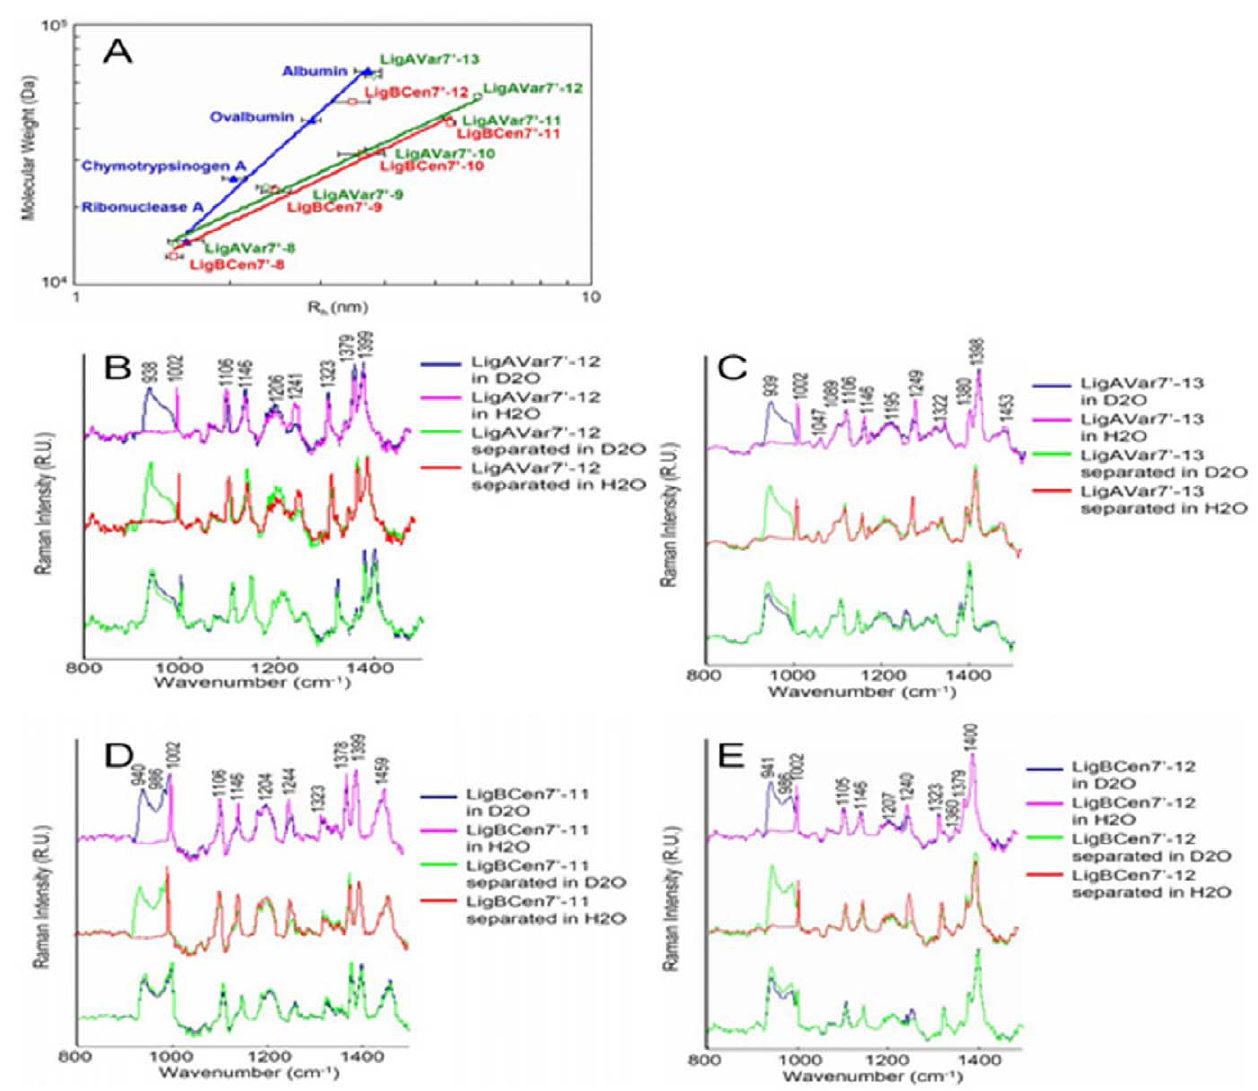
Figure 5. Terminal Ig-like domains contribute to the compact structure of Lig proteins. (A) Dynamic light scattering of standard molecular mass markers, LigAVar7’-13, LigAVar7’-12, LigAVar7’-11, LigAVar7’-10, LigAVar7’-9, LigAVar7’-8, LigBCen7’-12, LigBCen7’-11, LigBCen7’-10, LigBCen7’-9, LigBCen7’-8. The hydrodynamic radius (Rh) is plotted as a function of the molecular weight of each individual protein on a log-log scale. The molecular weights of the standards are indicated in Materials and Methods, and the molecular weight of the truncated Lig proteins are indicated in Table 5. (B to E) Comparative Raman spectroscopy of full-length LigAVar7’-12, LigAVar7’-13, LigBCen7’-11, LigBCen7’-12 and a stoichiometic mixture of its composite domains. The Raman spectra of full length or stoichiometrically mixed separated Ig-like domains of (B) LigAVar7’-12, (C) LigAVar7’-13, (D) LigBCen7’-11, and (E) LigBCen7’-12 were recorded in D2O and H2O.